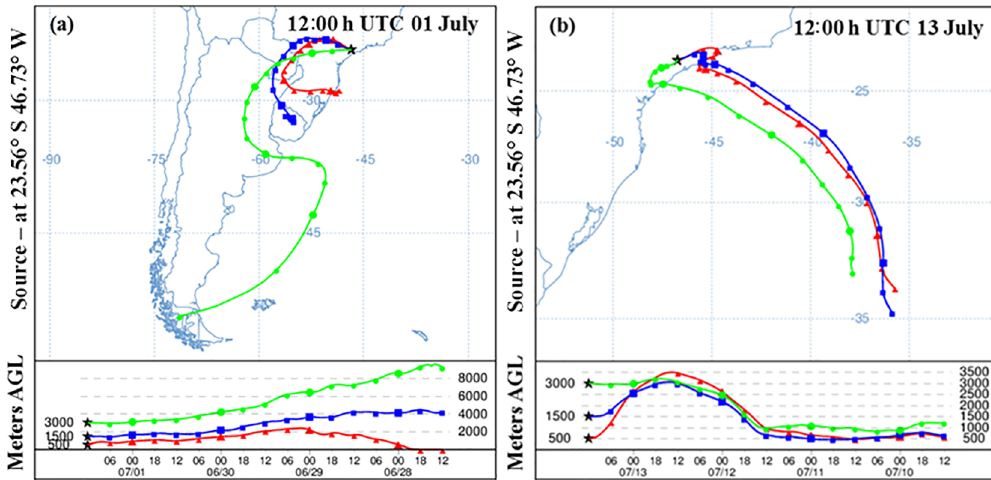
Figure 7. Backward air mass trajectories for the days (a) 1 July and (b) 13 July.